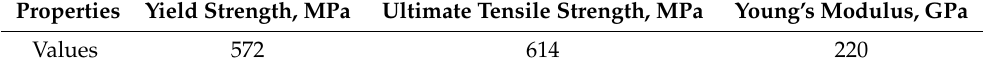
Table 3. Monotonic properties of API steel X65.